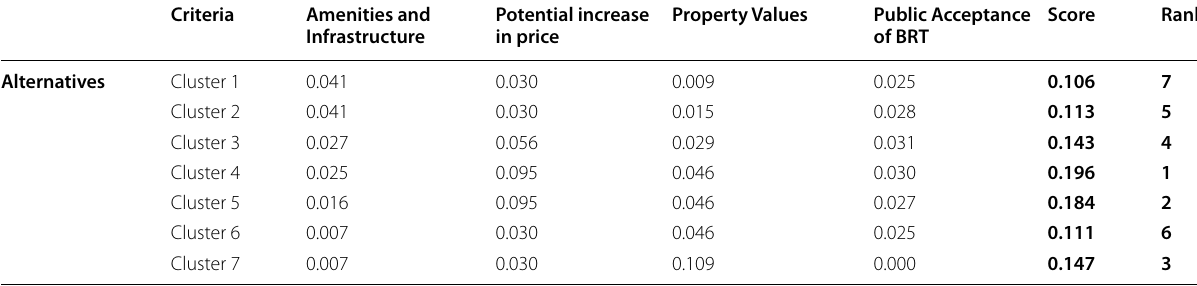
Table 5 Weighted Decision Matrix (BRT effects are taken into consideration) Criteria Amenities and